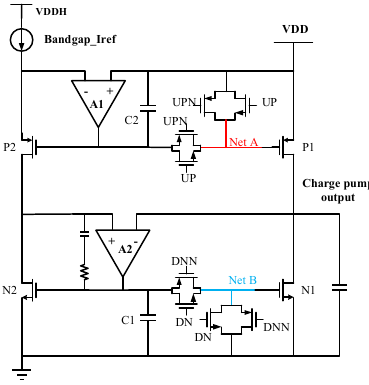
Figure 2. Low-voltage charge pump.